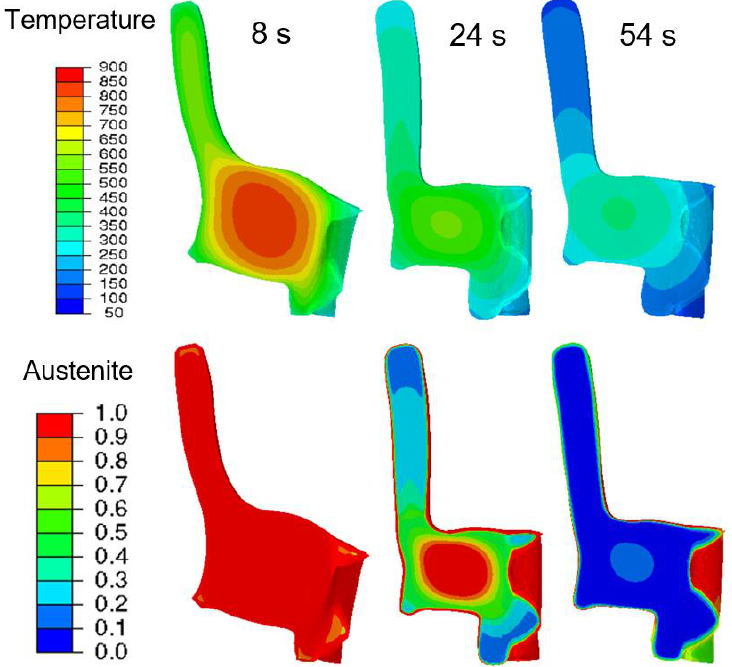
Figure 15. Contour plots and distribution of the temperature and austenite fractions at different quench times.